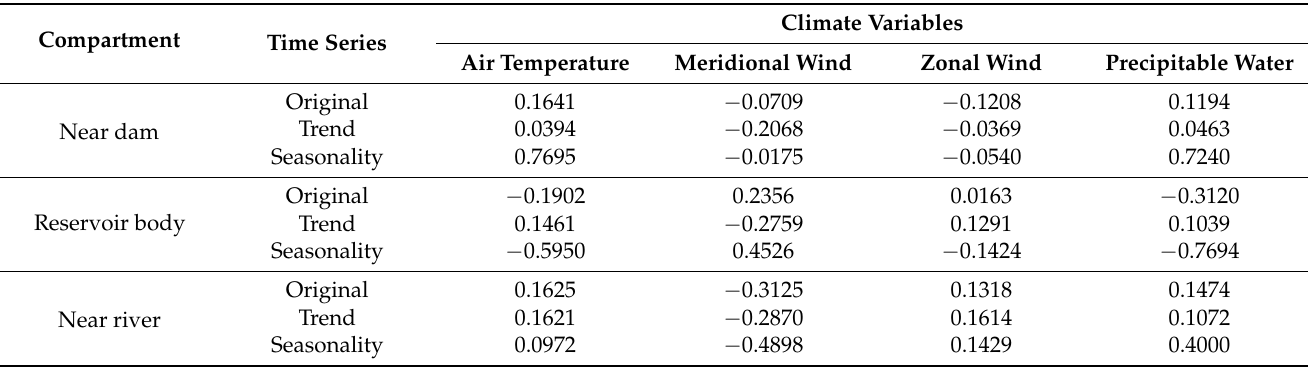
Figure 9. The NDVI time series (Y t ) and its seasonality (S t ) and trend (T t ) components of the segmented areas in the near river compartment (Sectors 10 to 12 from Figure 3c). Table 3. Correlation between the time series (original, trend, and seasonality components) of the mean NDVI and climate variables per reservoir compartment.